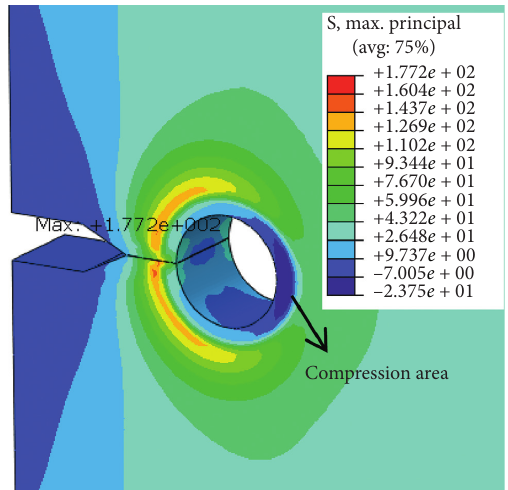
Figure 8: The principal stress of model with 30kN preload (MPa).